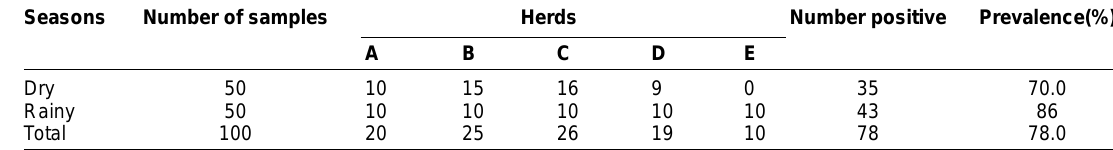
Table-2. Prevalence of gastrointestinal parasites of camels by age groups in Sokoto metropolis. Age groups (Years)